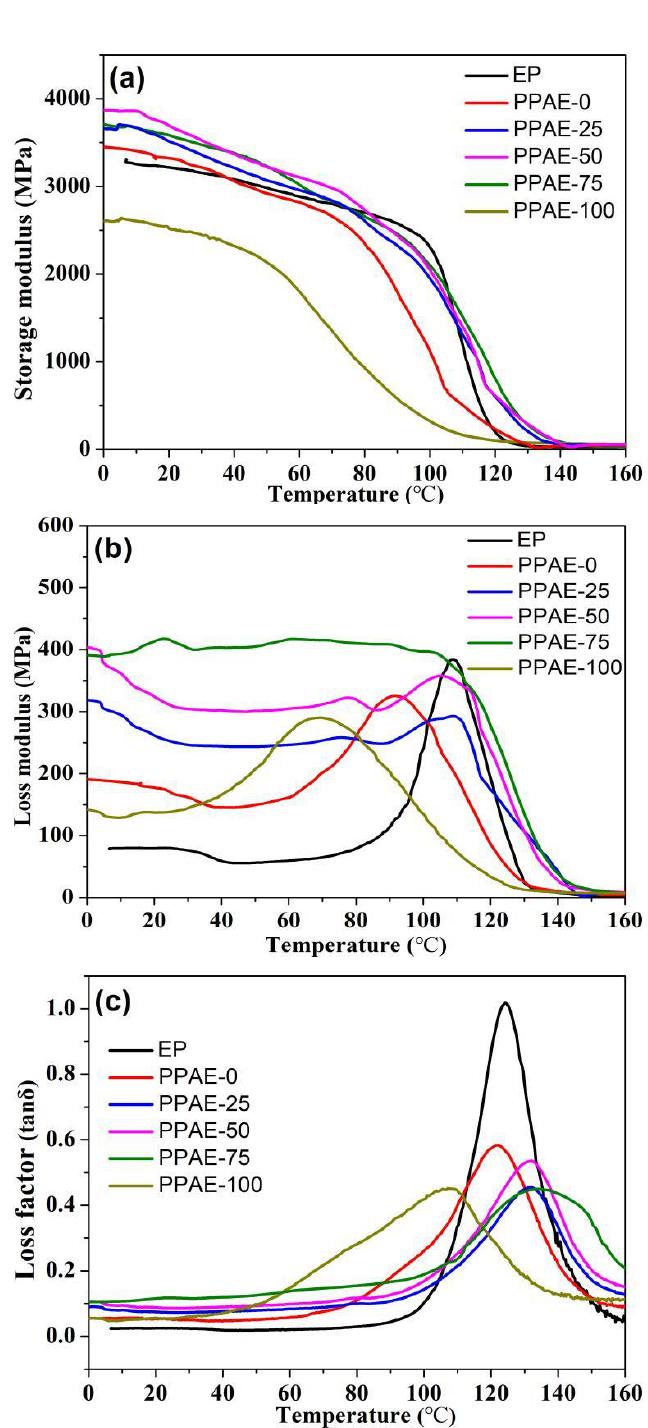
Figure 7. The variation plots of ( a ) the storage modulus, ( b ) loss modulus and ( c ) loss factor as a function of temperature (0–160 °C) for epoxy matrix and the PPAEs.